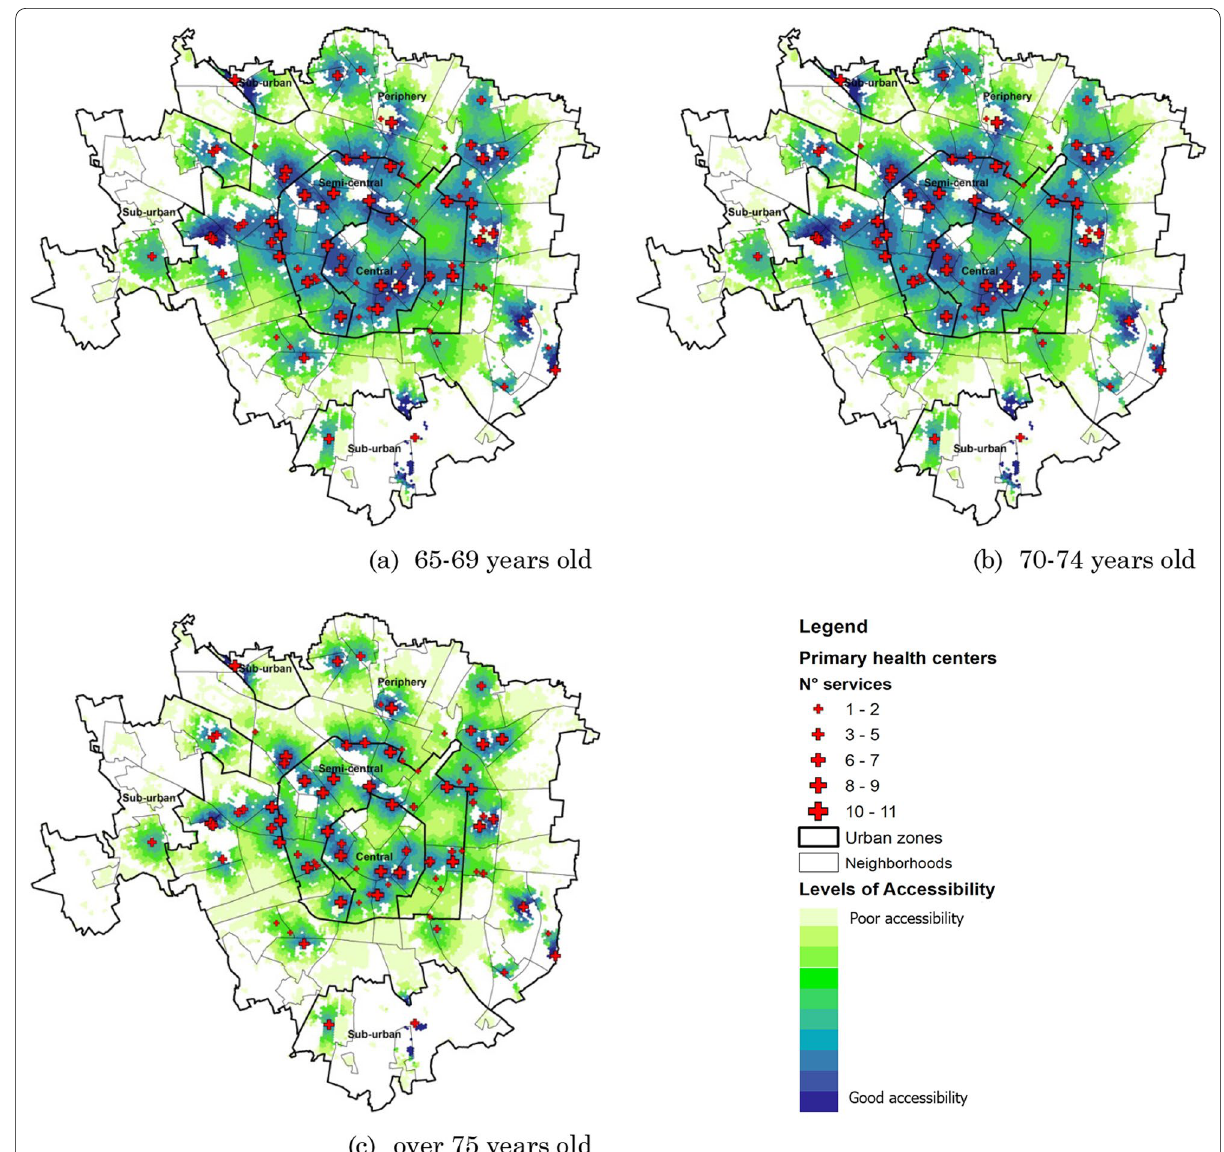
Fig. 5 Level of accessibility at the primary health centres in the Milan urban rings for the different elderly age